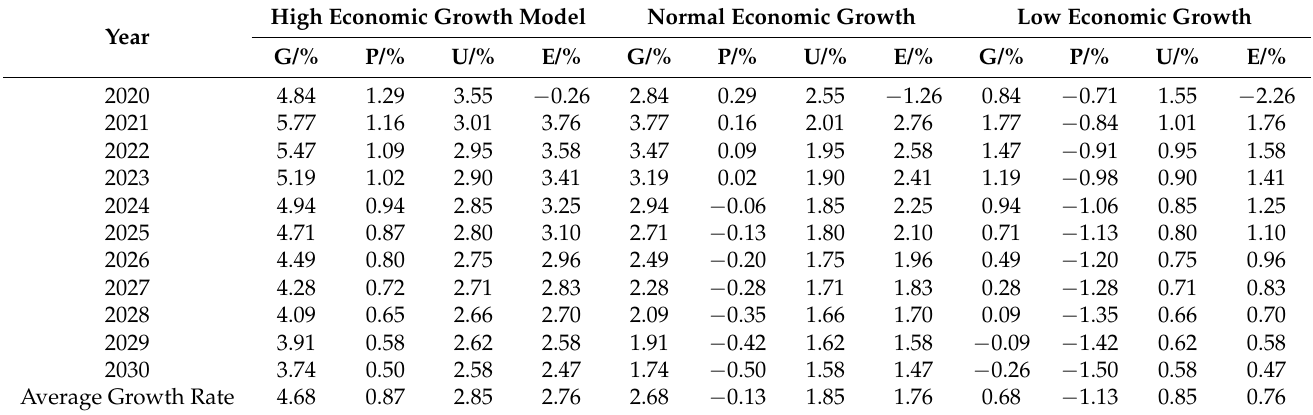
Table 4. EconomicvariablegrowthrateofelectricityandcoaldemandinShanxiProvinceinmultiplescenarios.